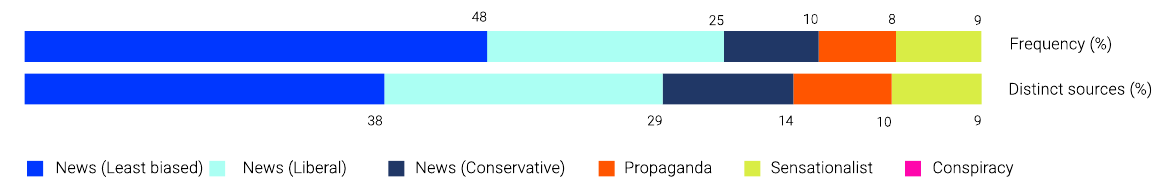
Figure 2. Categories of information websites shared on Reddit. Retrieved 25 March 2020; data source: